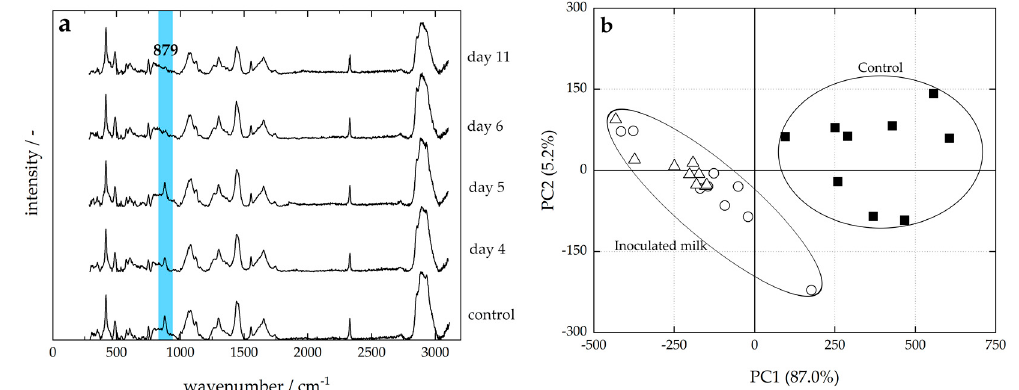
Figure 4. Representative Raman spectra of control milk and after 4, 5, 6, and 11 days of inoculation with Pseudomonas sp. ( a ), and the resulting score plot of PCA ( b ) of control ( ■) and samples after 6 ( ○) and 11 ( △) days of incubation. Spectra are offset for clarity. Highlighted in blue is the peak corresponding to the indole ring of tryptophan.